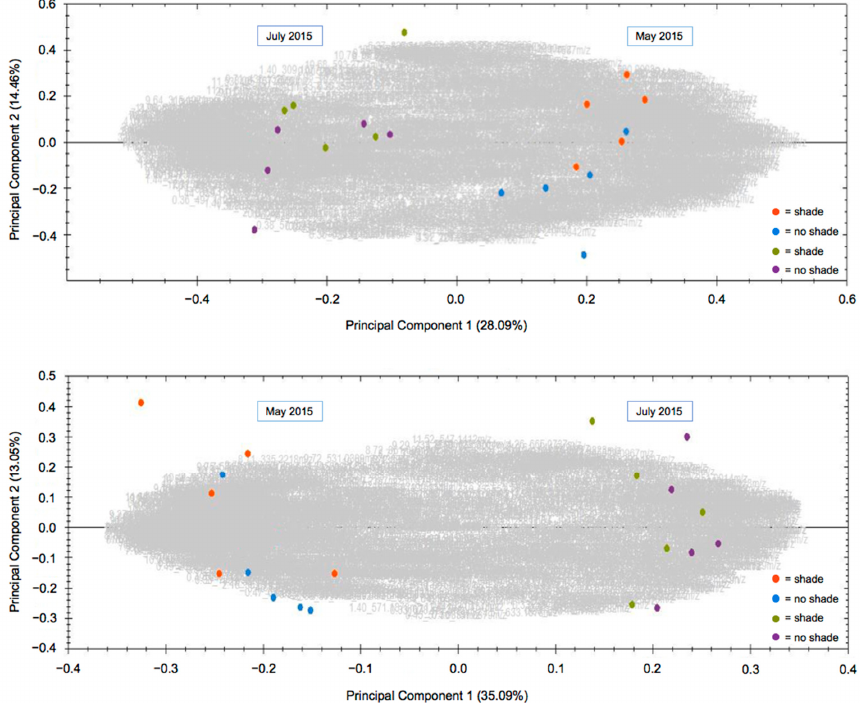
Figure 2. Principal component analysis (PCA) comparing leaves from no shade and shade-grown S. lanceolata ( top ) and S. marilandica ( bottom ) grown during May 2015 and July 2015. Each dot represents a biological replicate, and the grayed-out numbers are individual mass spectral features.